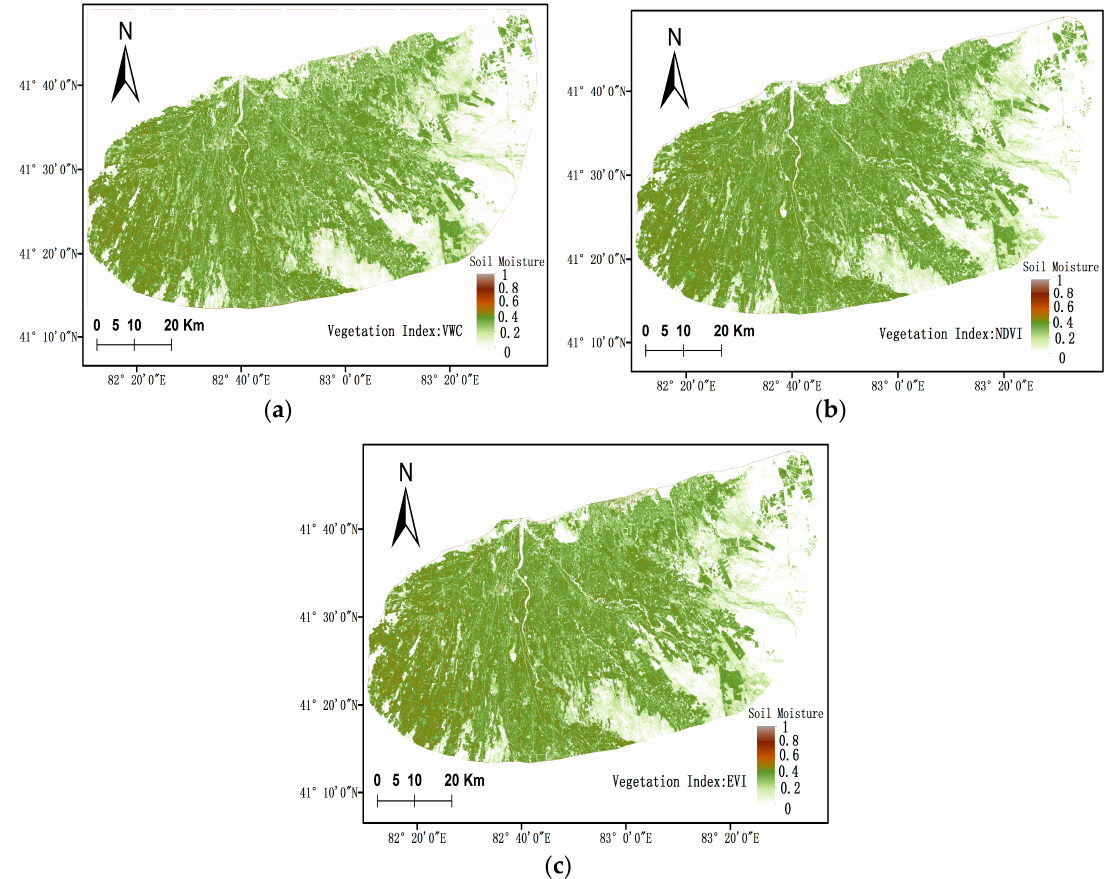
Figure 11. The spatial of soil moisture ( a ) VWC; ( b ) NDVI; ( c ) EVI.